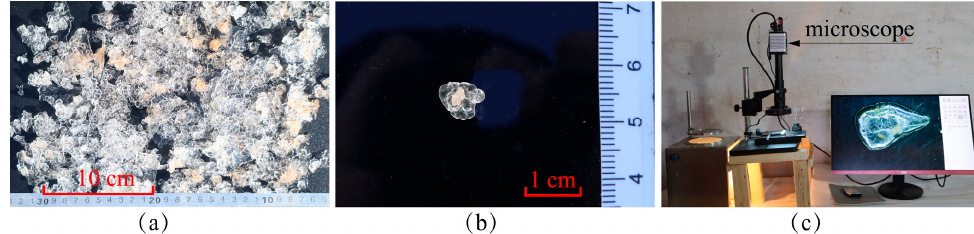
Figure 3. Process of frazil particles observation: ( a ) frazil particles on the black acrylic plate; ( b ) separated frazil particles; ( c ) the setup to observe the frazil particles under the microscope.